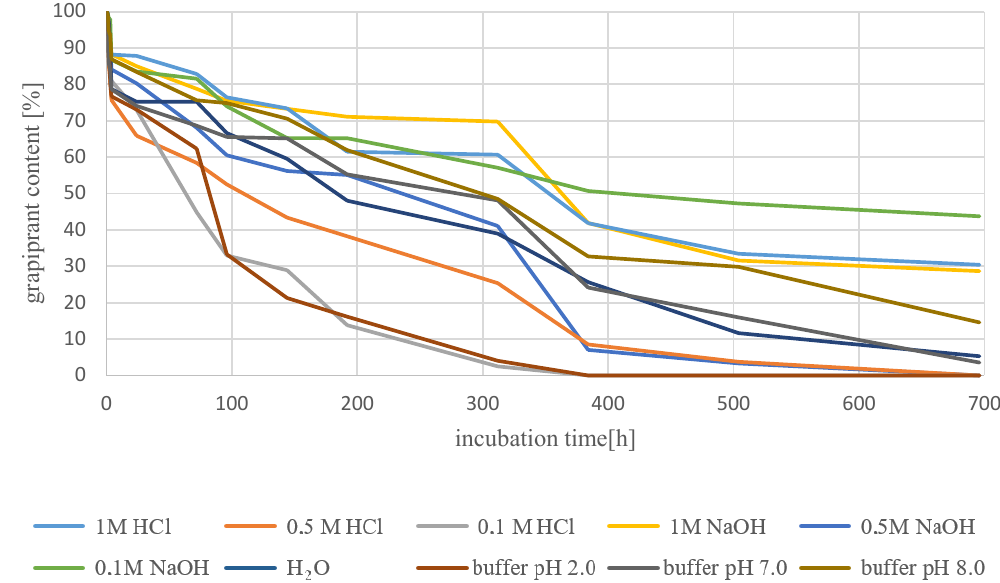
Degradation at room temperature was carried out for 63 days (1512 h). The